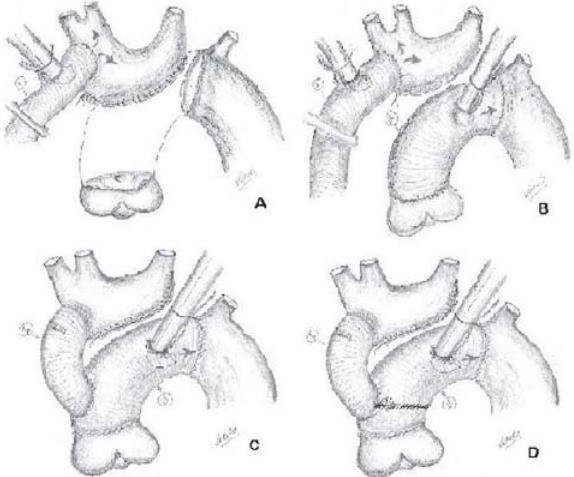
Fig. 2 – A: Fechamento do retalho com sutura contínua com polipropileno 4-00. Retirada do “clamp” do tronco braquiocefálico que permite perfusão cerebral anterógrada bilateral; B: Implante do tubo II na aorta distal e posicionamento de cânula arterial para início da perfusão e reaquecimento corpóreo; C: Implante do